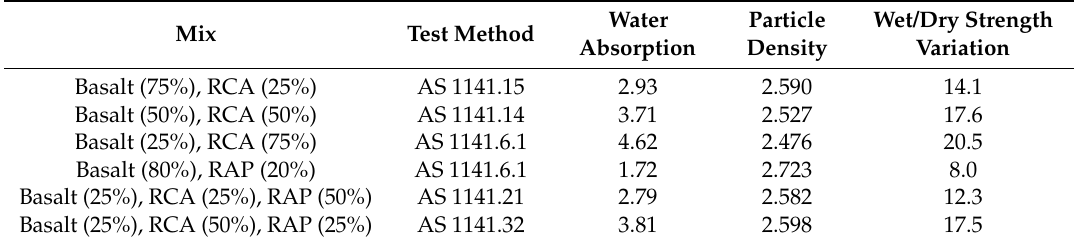
Table 11. Summary of Tests Results for Evaluation of Mix of Coarse Aggregates Properties.